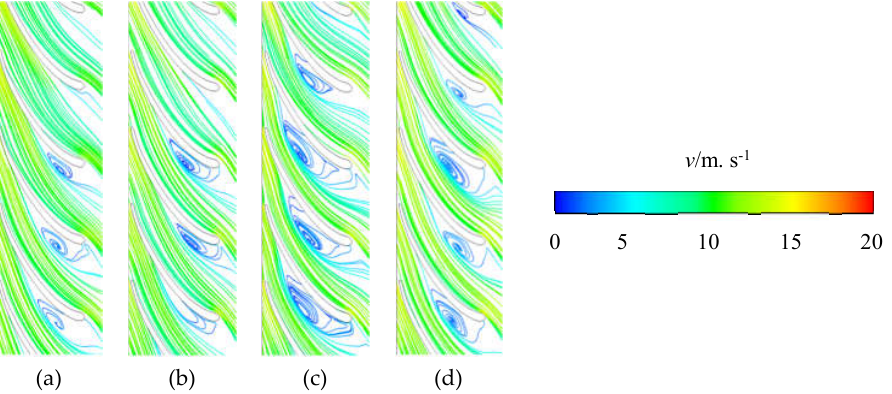
Figure 15. Streamline diagram of the velocity of the diffuser, ( a ) 0.3 mm, ( b ) 0.6 mm, ( c ) 0.9 mm, ( d ) 1.2 mm.